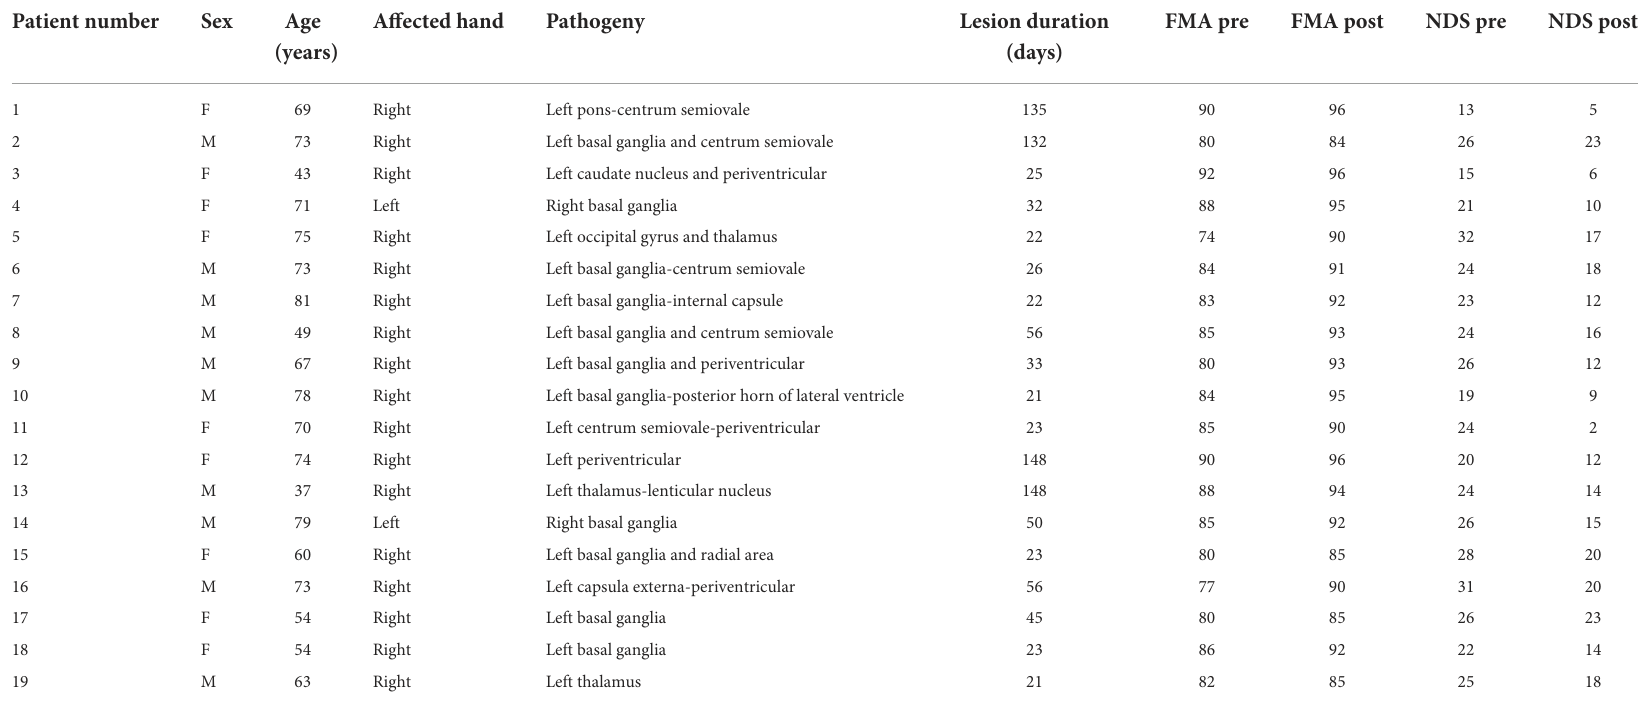
TABLE 1 Demographical and clinical